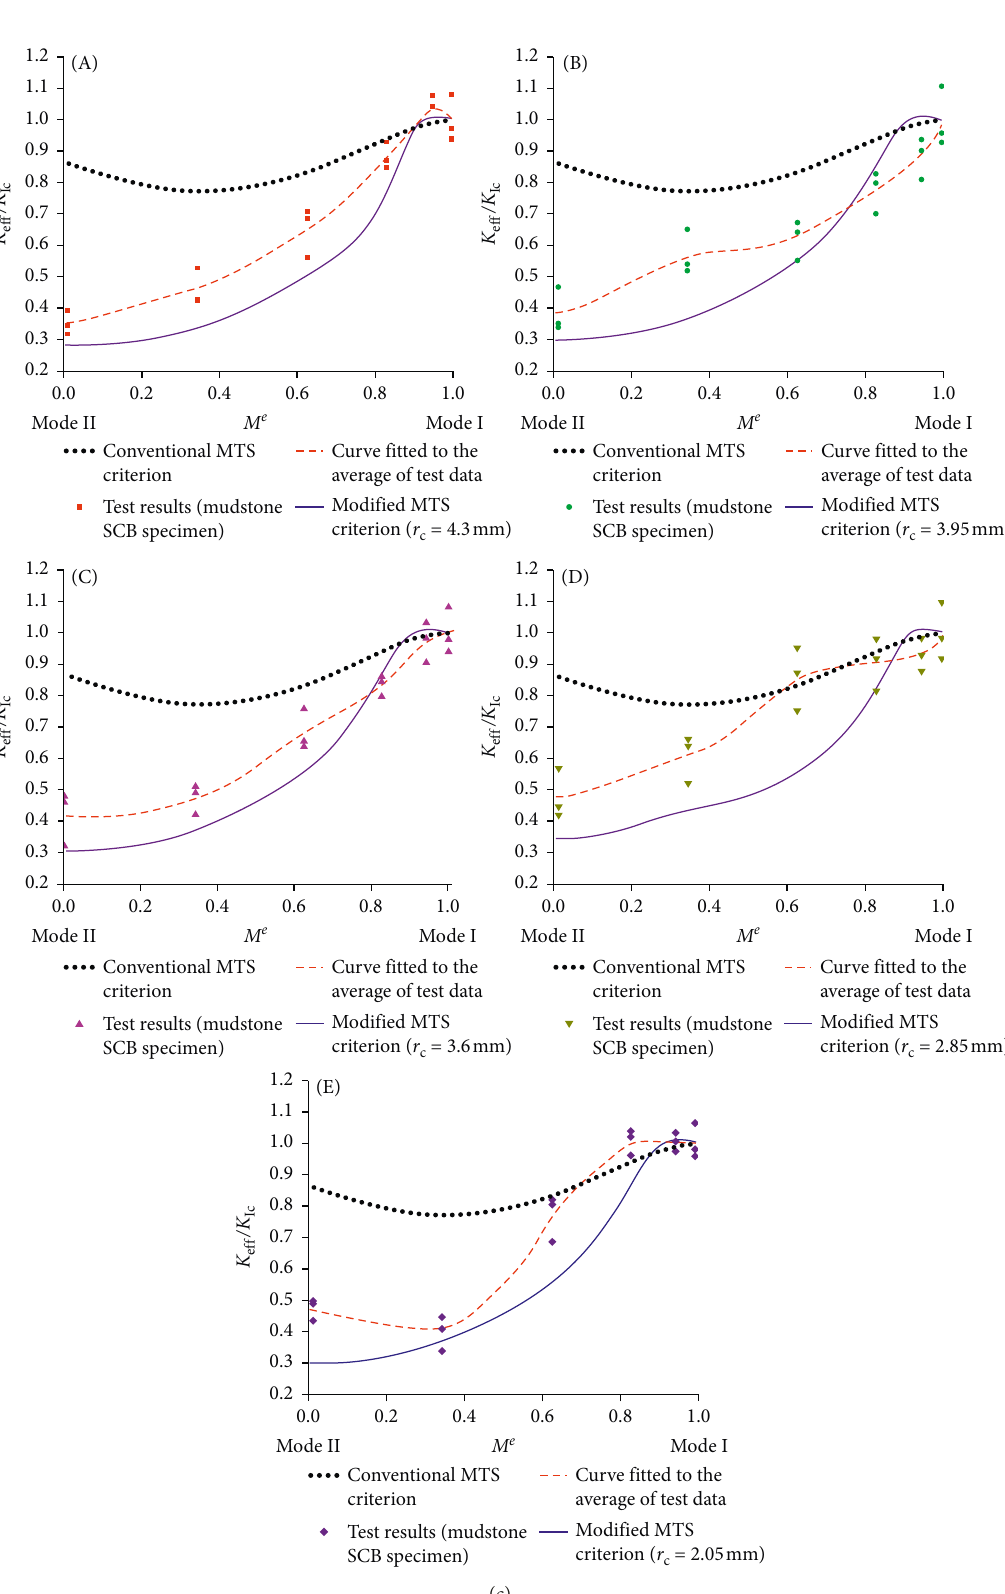
Figure 10: Comparison of K eff / K Ic test ratio of the three types of the mudstone SCB specimens with theoretical values by modified MTS criterion. (a) Type A, (b) Type B, and (c) Type C specimens for soaking 0 (A), 50 (B), 100 (C), 200 (D), and 300 (E)